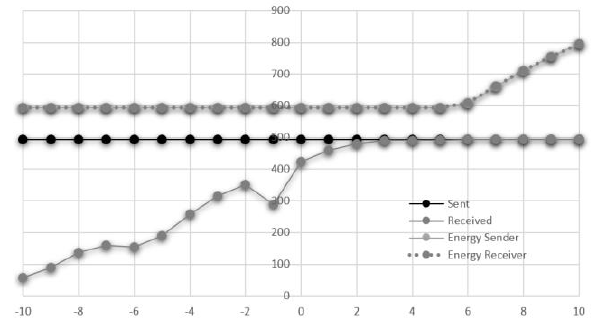
Figure 10. Remaining Energy vs Transmission Power under Scenario 1b .